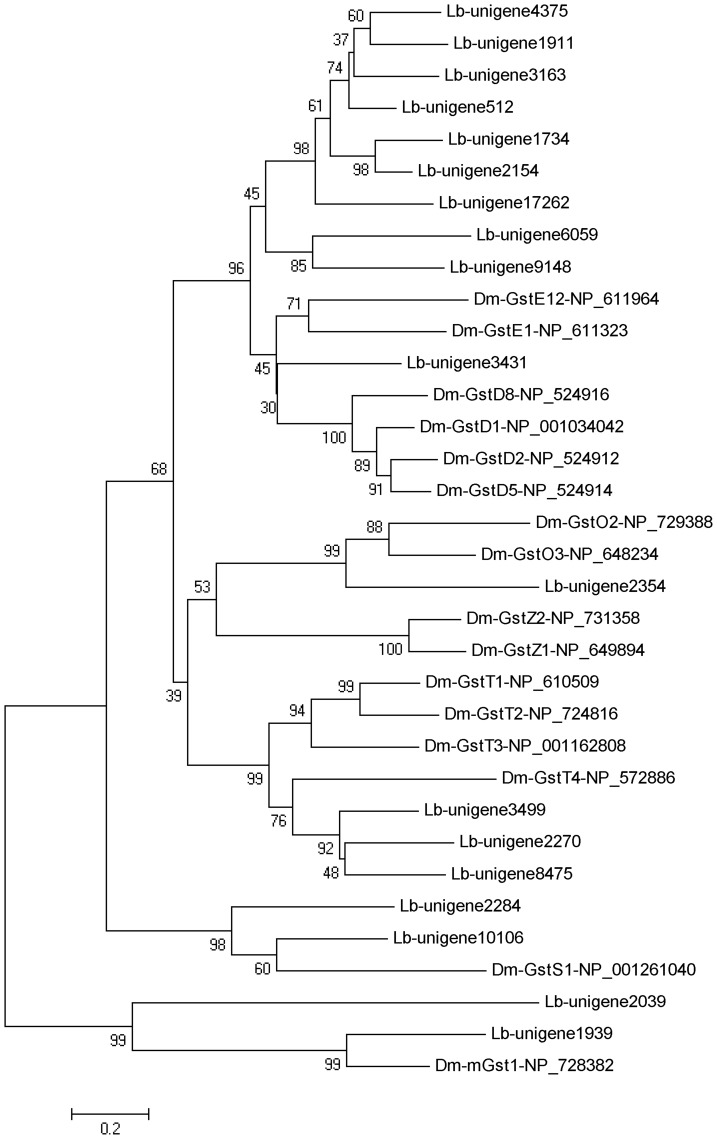
Phylogenetic tree of glutathione S-transferases from Liposcelis bostrychophila (Lb) and Drosophila melanogaster (Dm).The tree was constructed from the multiple alignments using MEGA 5.0 software and generated with 1,000 bootstrap trials using the neighbor-joining method. The numbers indicate the bootstrap confidence values obtained for each node after 1,000 repetitions.